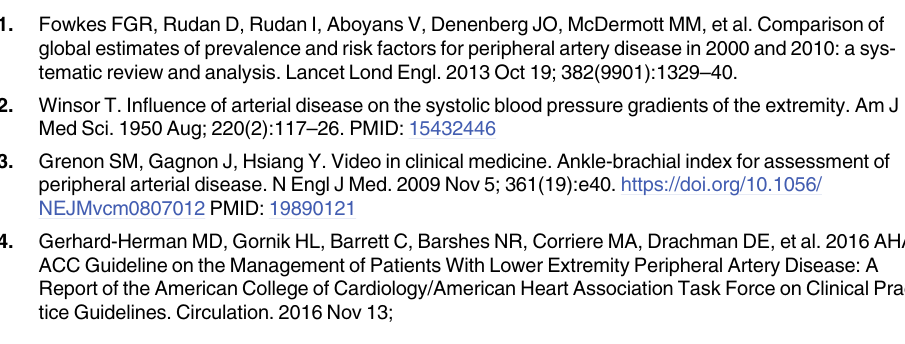
S3 Table. Association between test for identifying and stenosis � 50% in any limb from aorta till popliteal artery in the overall population ( n = 126 limbs ) adjusted for sex, antihy- pertensive treatment, dyslipidemia, diabetes, tobacco. OR: Odds ratio; ABI: Ankle Brachial Index, TcPO2, Transcutaneous oxygen pressure measurements. DROP, Delta from rest oxy- gen pressure. S4 Table. Association between test for identifying and stenosis � 50% in any limb among the 60 limbs with normal ABIs ( > 0.91) adjusted for sex, antihypertensive treatment, dysli- pidemia, diabetes, tobacco. OR: Odds ratio; ABI: Ankle Brachial Index, TcPO2, Transcutane- ous oxygen pressure measurements. DROP, Delta from rest oxygen